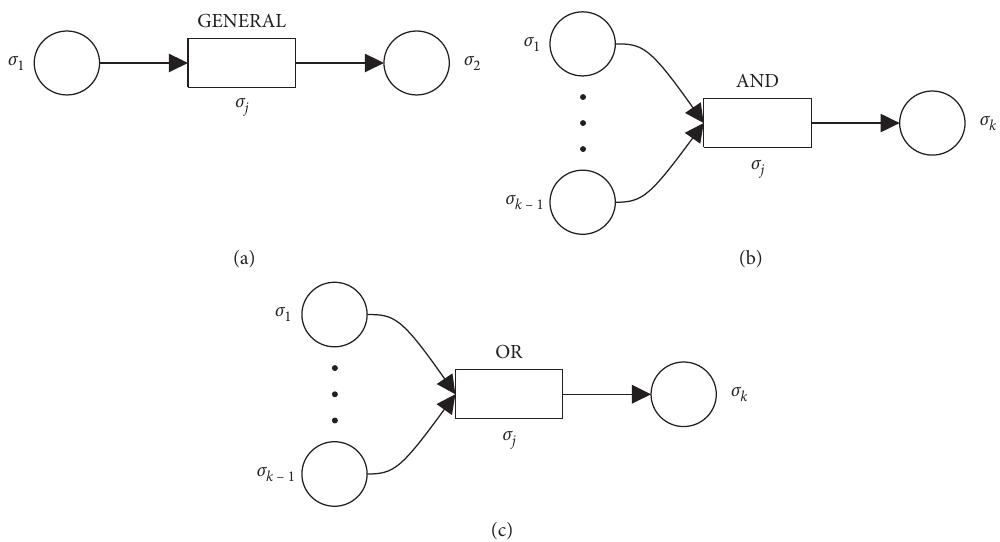
Figure 1: rMFRSNPS-based models for fuzzy fault production rules. (a) GENERAL rule; (b) compound AND rule; and (c) compound OR